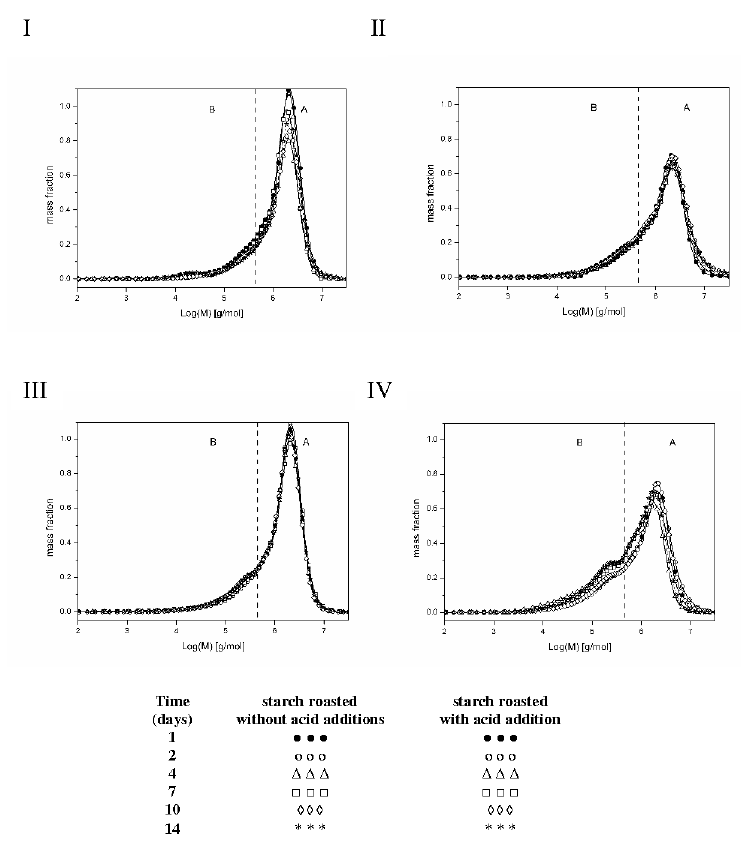
Figure 2. Molar mass distribution profiles of starches roasted without acid addition dissolved in DMSO (I), starches roasted without acid addition dissolved in NaOH (II), starches roasted with acid addition dissolved in DMSO (III), and starches roasted with acid addition dissolved in NaOH (IV). Table 1. Weighted average of molar masses and molar dispersity of starches retained for various periods of time with or without citric acid after dissolution in DMSO or NaOH.